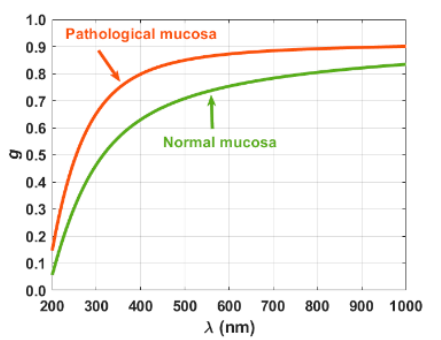
Figure 11. Calculated g ( λ ) curves for the normal and pathological mucosa. Figure 11 shows that both tissues present a good wavelength dependence for g in the entire spectral range – g increases with wavelength from the deep-UV to NIR. The pathological mucosa presents higher g values than the normal mucosa in the entire spectral range, which suggests a higher scattering directionality at all wavelengths. Considering the range between 200 and 230 nm, such